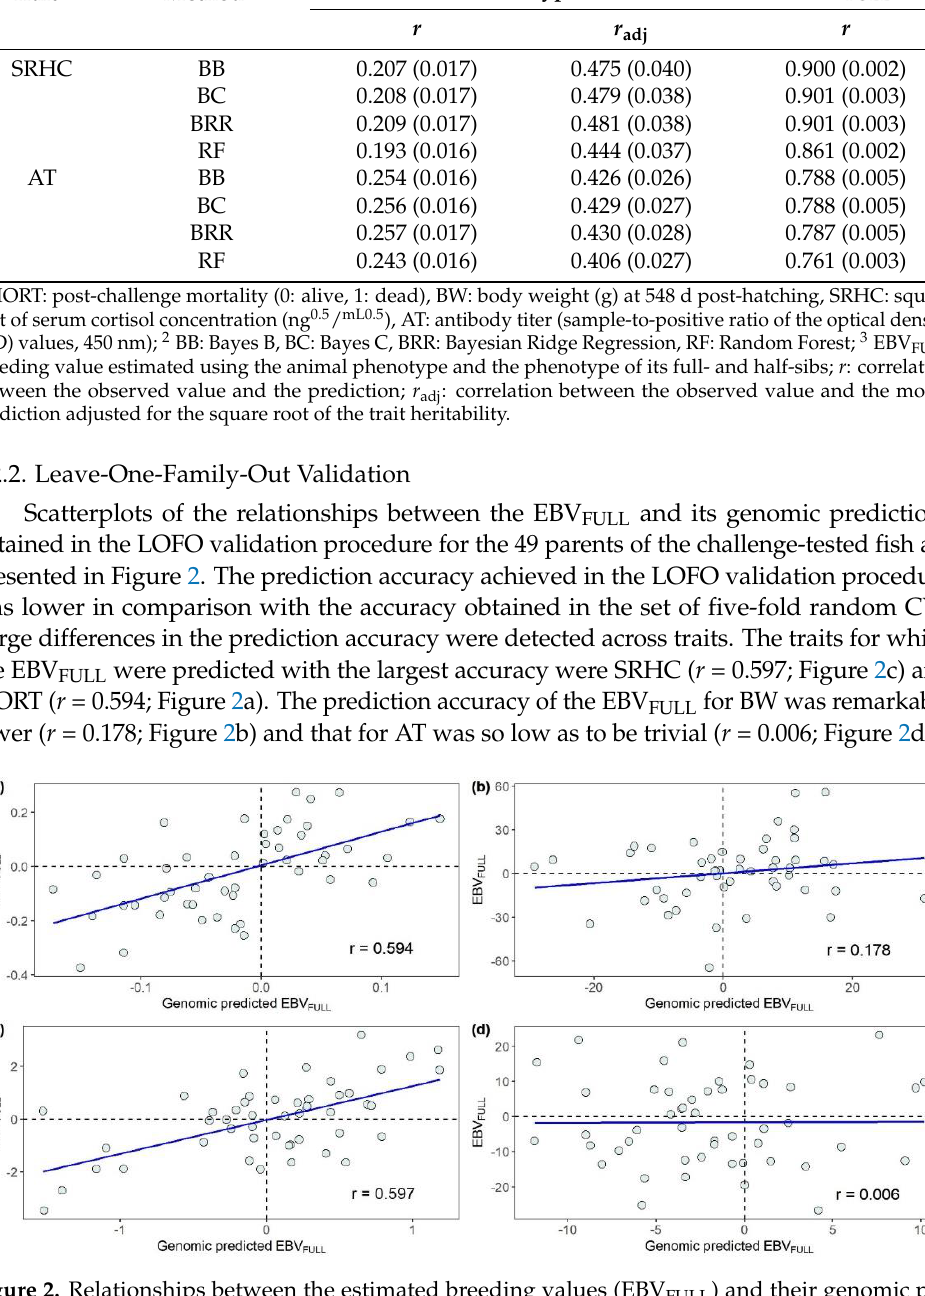
Figure 3. ROC curve for the classification of VNN mortality based on the estimated breeding values of the trait (EBV FULL : breeding value estimated using the animal phenotype and the phenotypes of its full- and half-sibs). AUC: area under the ROC curve; ACC: classification accuracy computed as (true positives + true negatives)/number of samples; MCC: Matthews correlation coefficient. Table 2. Average metrics (SD) of classification performance for different classifiers of VNN mortal- ity in 16 independent five-fold cross-validations. Classifier 1